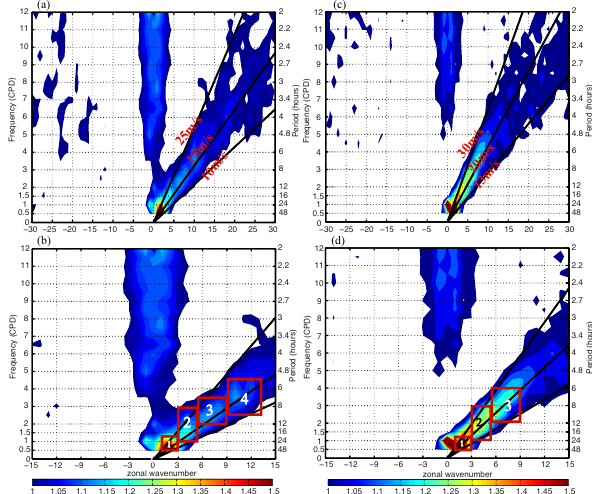
Figure 9. Top: normalized power spectra with raw values in Fig. 8a and c divided by smoothed values in Fig. 8b and d for (a) East Asia and (c) North America. Bottom: as in the top panels but with zoomed - in display to include only wavenumbers from − 15 to 15. The red rectangles denote for the spectral ranges from SR1 to SR4 described in Table 1.